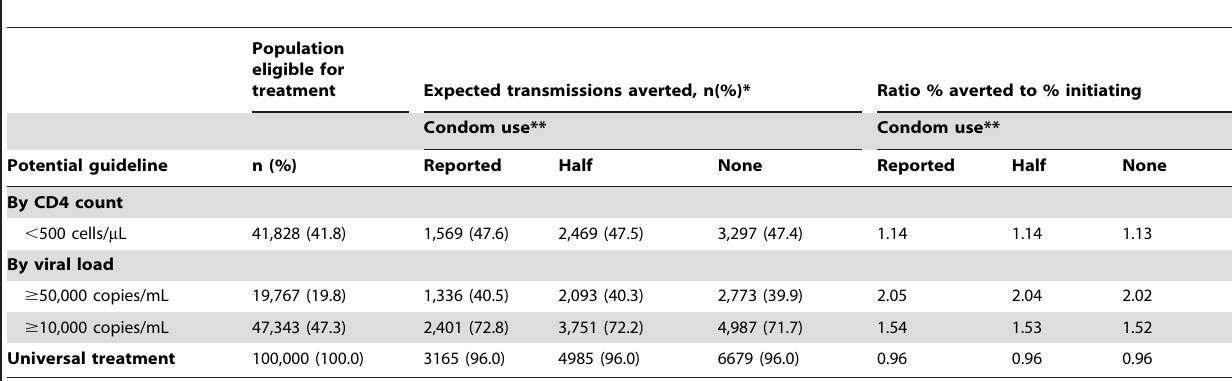
Table 2. Comparison of potential guidelines for ART initiation: population size requiring treatment, transmissions averted, and the ratio of % averted to %